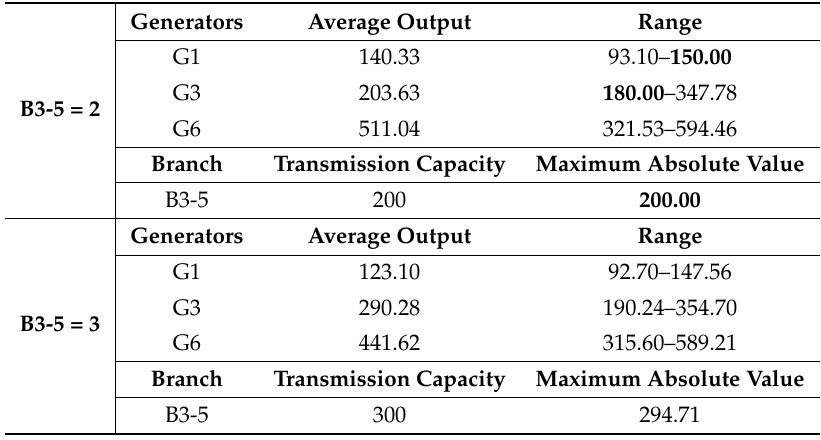
Table 3. Power output from generators and power flow from transmission lines in case 1